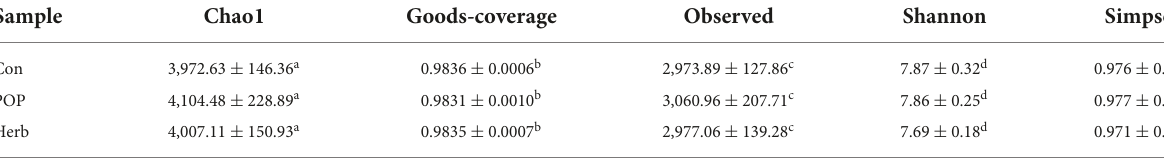
TABLE 1 Alpha-diversity indices of the fecal microbiota.